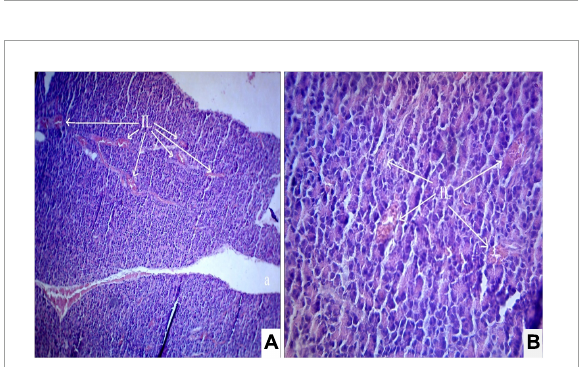
FIGURE4 (A,B) Photomicrograph of a diabetic rats treated with Solanum torvum fruits extract (120 mg/kg/b.wt.) section from pancreas showed minimal restoration of normal cellular population and size of islet cells. The acinar cells are seen to be normal. (A) H & E 10X; (B) H & E 40X. IL, islets of Langerhans